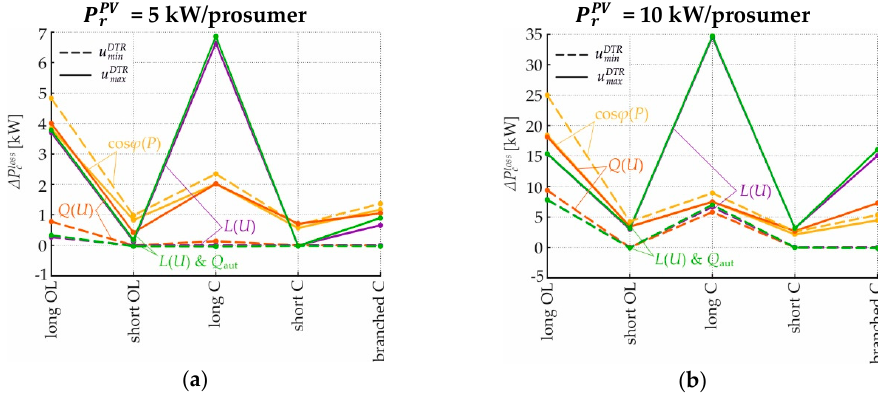
Figure 19. Additional grid losses provoked by different control strategies for minimal and maximal DTR primary voltages, different LV test-feeders and different PV-penetrations: (a) 5 kW/prosumer; DTR primary voltages, di ff erent LV test-feeders and di ff erent PV-penetrations: ( a ) 5 kW / prosumer; (b) 10 kW/prosumer. ( b ) 10 kW /